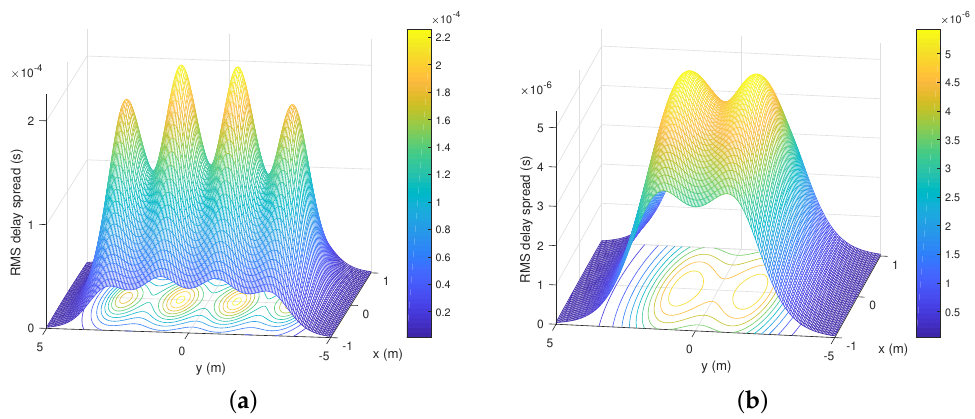
Figure 8. RMS delay spread distribution in the underground mining VLC scenarios. for the ( a ) mining roadway and ( b ) mine working